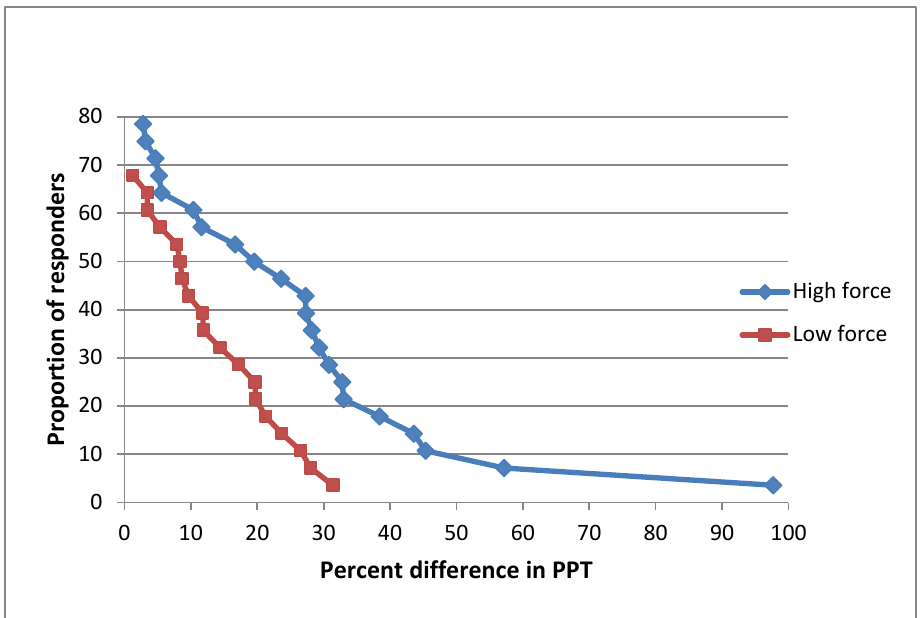
Figure 5. Cumulative proportion of responders analysis graph Mid Forearm after high and low mo ‐ bilizations .